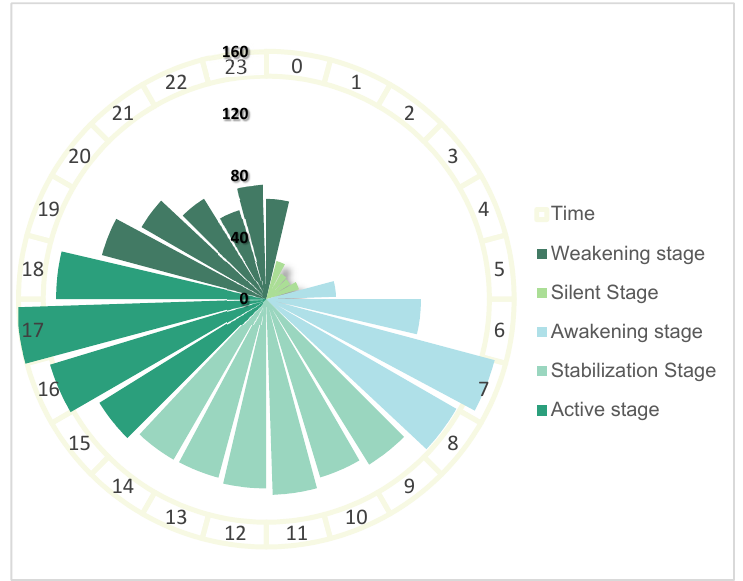
Figure 3. Intensity of total population activity. Note: The sectors indicate the intensity of population activity at different periods and the rings are the corresponding time points 0–23.